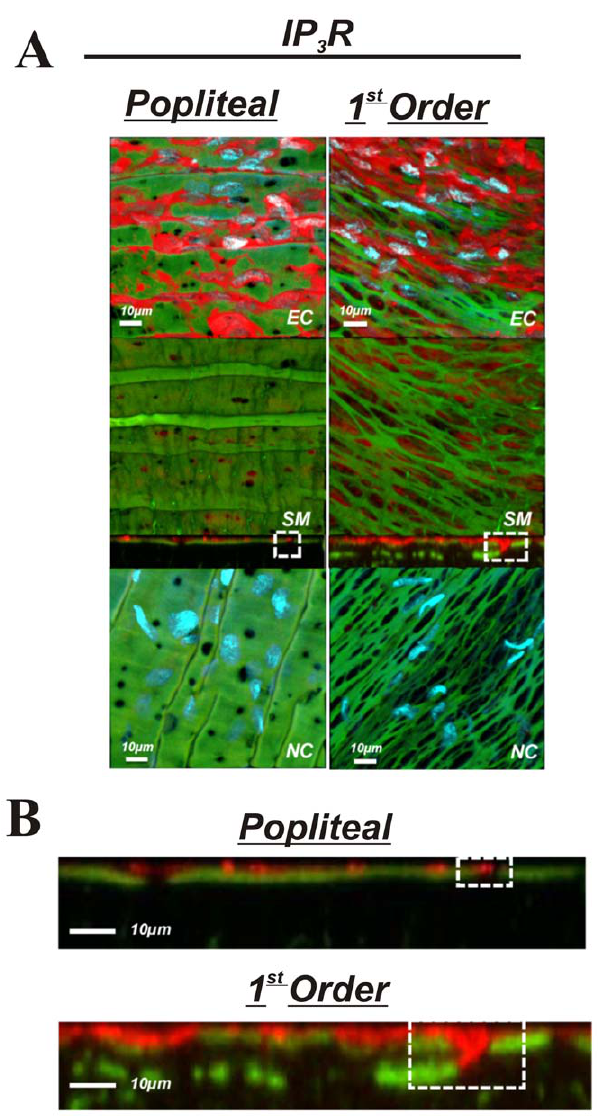
Figure 7. IP 3 R in skeletal muscle arteries. A: skeletal muscle popliteal (left) and 1 st order (right) arteries immunolabeled for IP 3 R (top 3 panels) or no primary antibody control (bottom panel). The top image represents a composite of DAPI-stained nuclei in the endothelium, autofluorescence of the internal elastic lamina (green), and IP 3 R immunolabeling immunolabeling (red), and a compressed z-stack image endothelial cell surface (EC, top panel). The second image is a compressed z-stack image from the perspective of the smooth muscle face (SM), the third image is a cross-sectional slice, and the fourth is a compressed z-stack image of a no primary antibody control (NC).Red staining indicates endothelial expression of IP 3 R. B: Magnified image of the cross-sectional view of the IEL. Note the sections highlighted by dotted square boxes indicating larger MEC and area of IP 3 R staining in 1 st order arterioles. Bar=10 m m. Representative of images from tissue isolated from at least 3 animals.